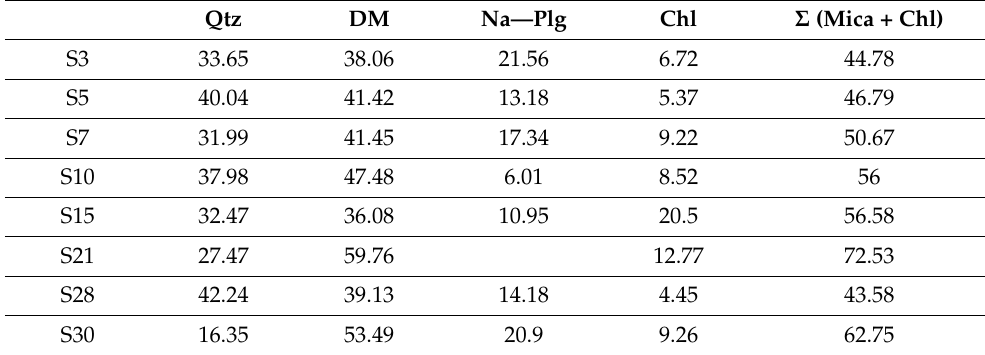
Table 1. The main soil minerals-quantitative (%) mineral composition